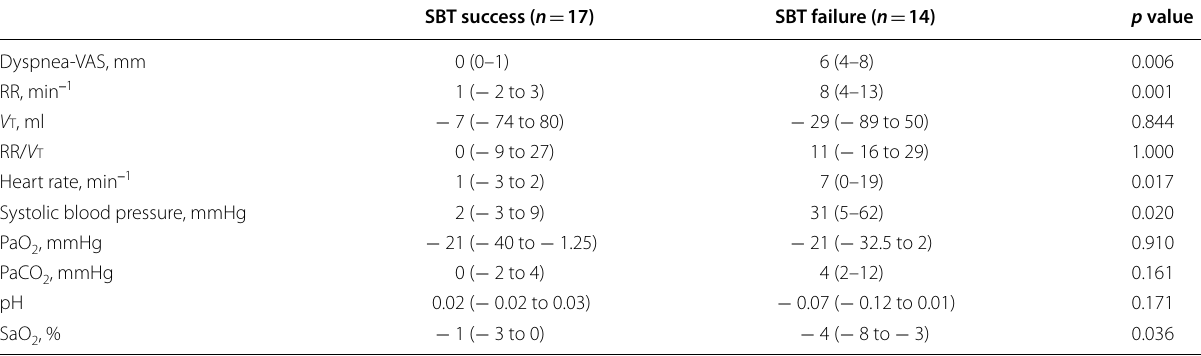
The evolution is described by the difference in variables between the initiation and end of the spontaneous breathing trial Data are provided as median (interquartile range) and number